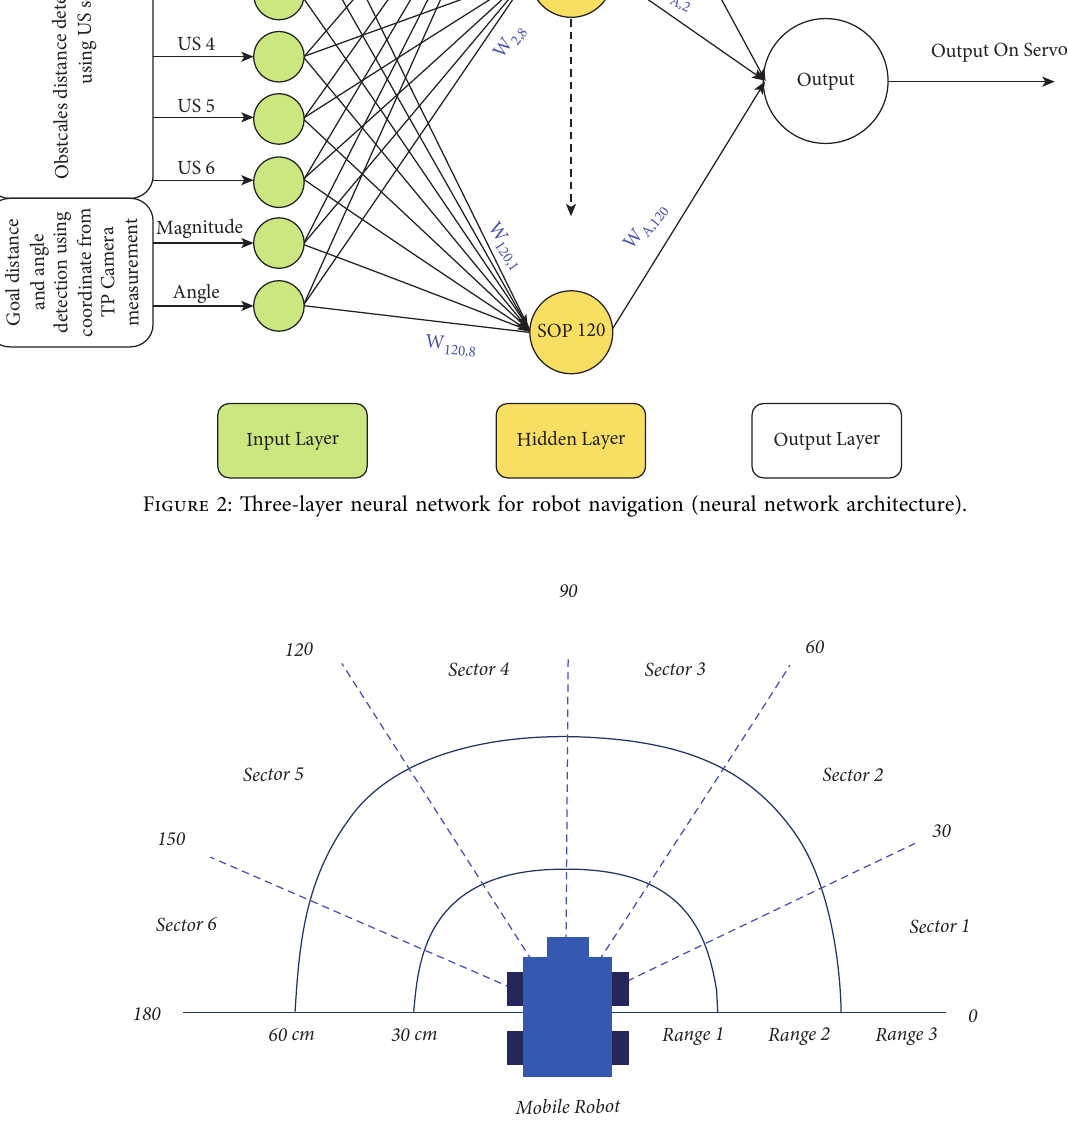
Figure 3: Workspace of the arranged environment’s data.